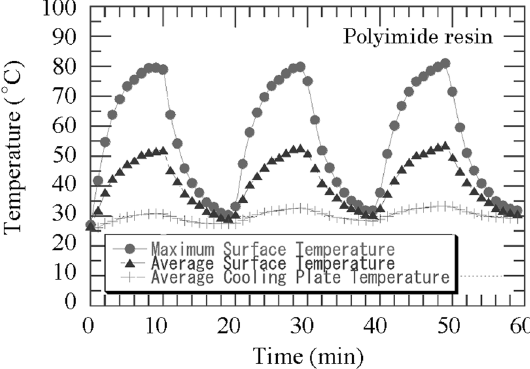
FIG. 10. Cyclic pattern of endurance test: 10 min of power on and 10 min of power off were repeated for 200 times. Only the first few cycles of endurance test for the case of a polyimide- resin-adhered core are